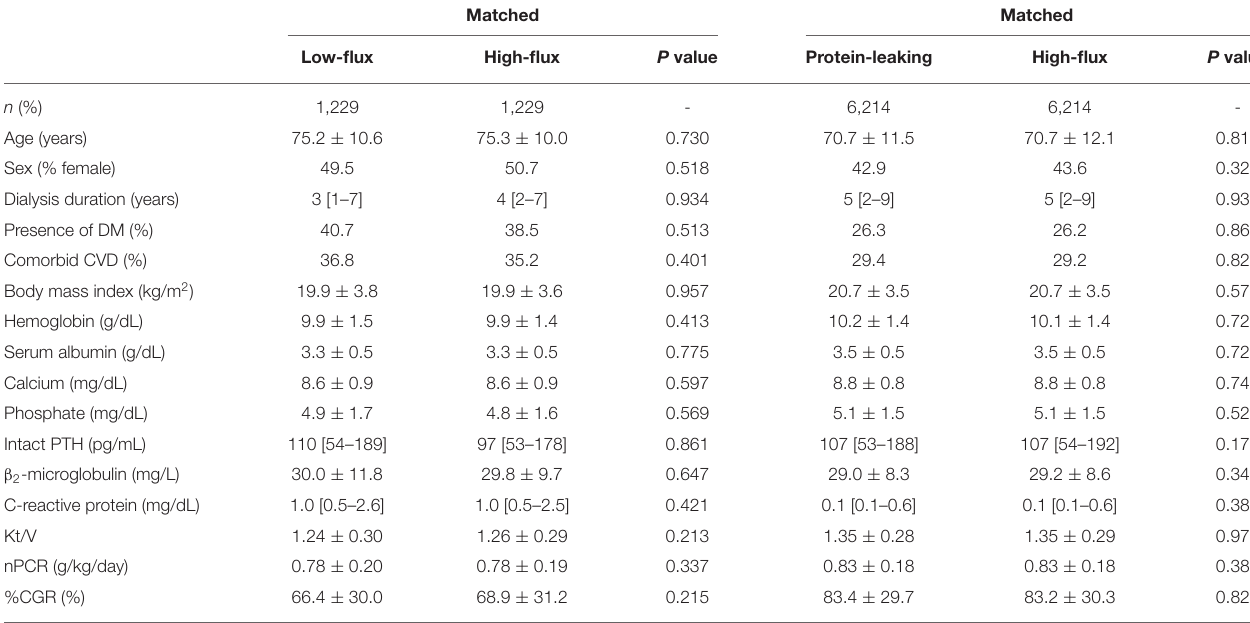
TABLE 4 | Baseline characteristics after propensity score matching between high-flux dialyzers (reference) and other dialyzer types. Matched Matched Low-flux High-flux P value Protein-leaking High-flux